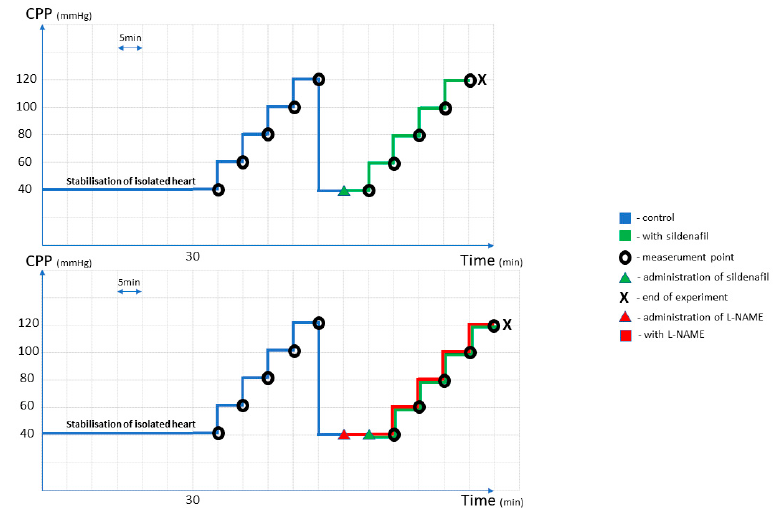
Figure 7. Control and experimental protocol and drug administration scheme, once the heart was isolated from the rat.